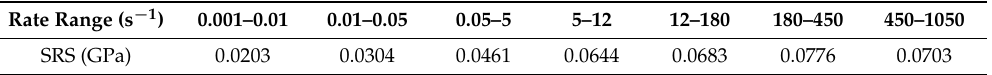
( b ) Figure 4. Electron backscatter diffraction ( EBSD) maps of samples tested at ( a ) 0.001 s − 1 and ( b ) 1050 s − 1 .